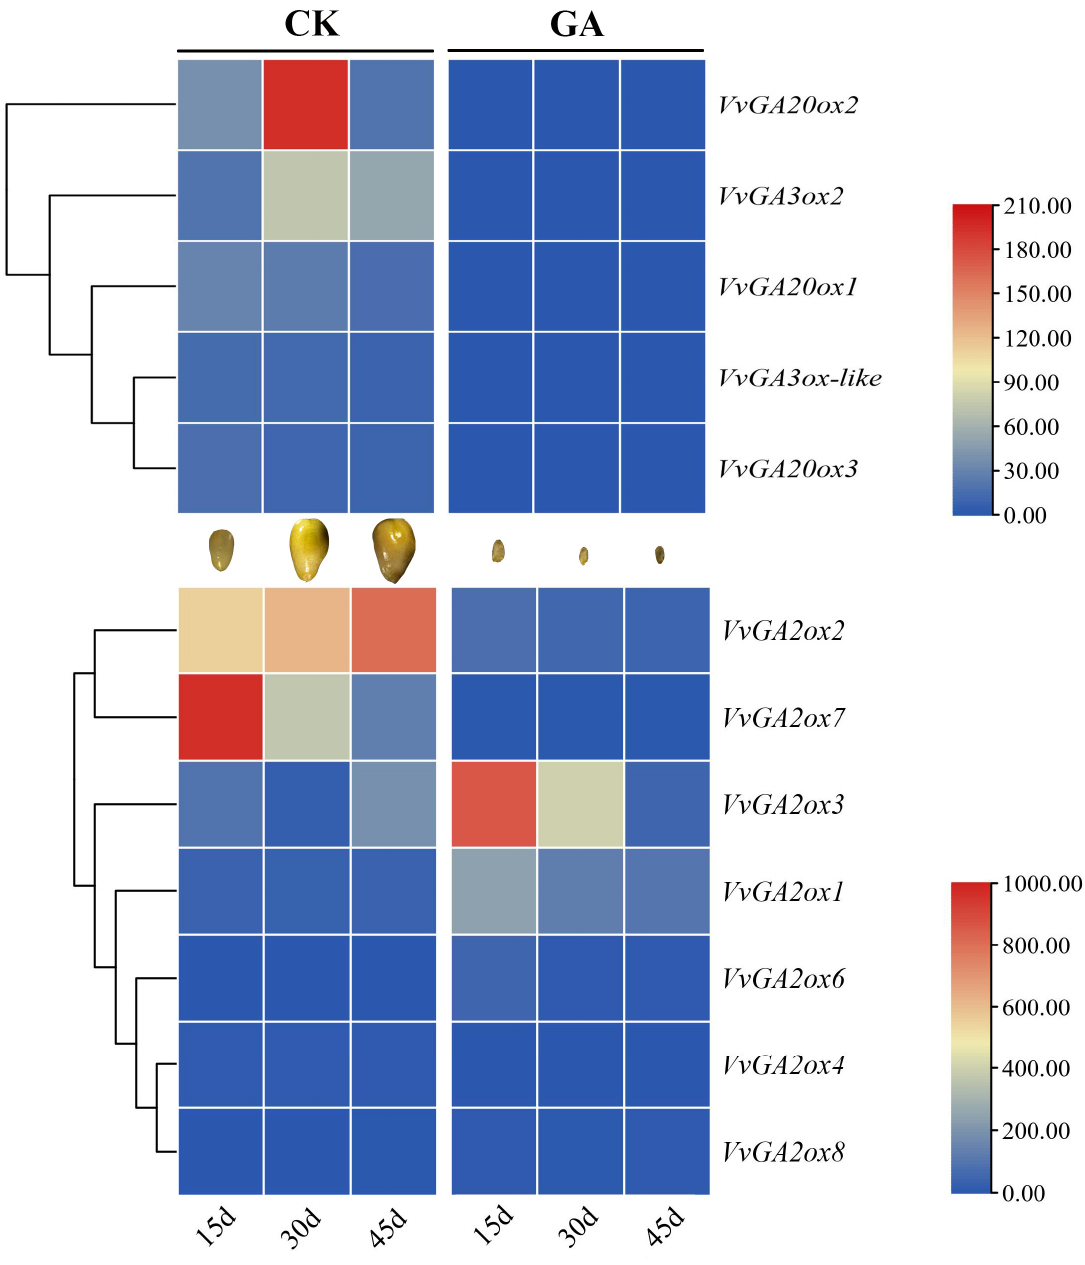
Figure 7. Expression modes of gibberellin catabolic enzymes according to time course experiment during grape and seed